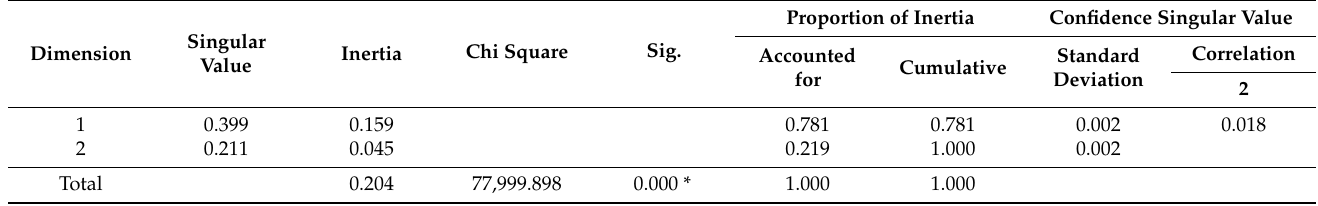
Table A4. Summary of correspondence. Positioning and traffic obtained from social networks.